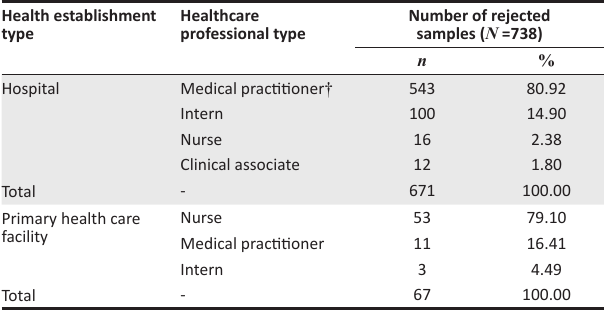
TABLE 2: Number of HIV serology samples rejected, by health establishment and healthcare professional